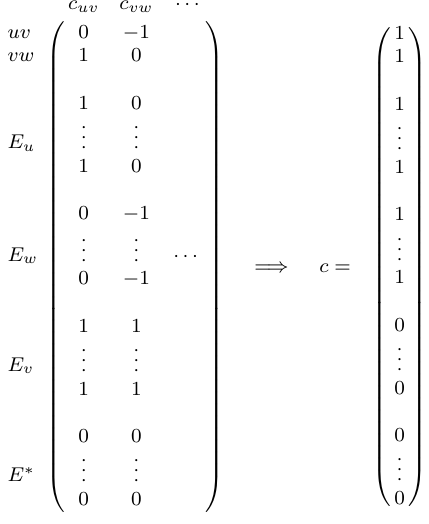
Fig. 6: An operation on two columns of A